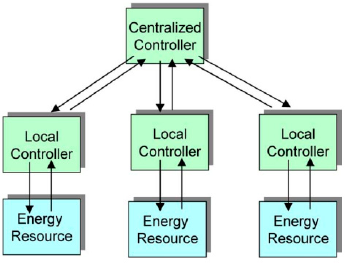
Figure 1. Central control structure.